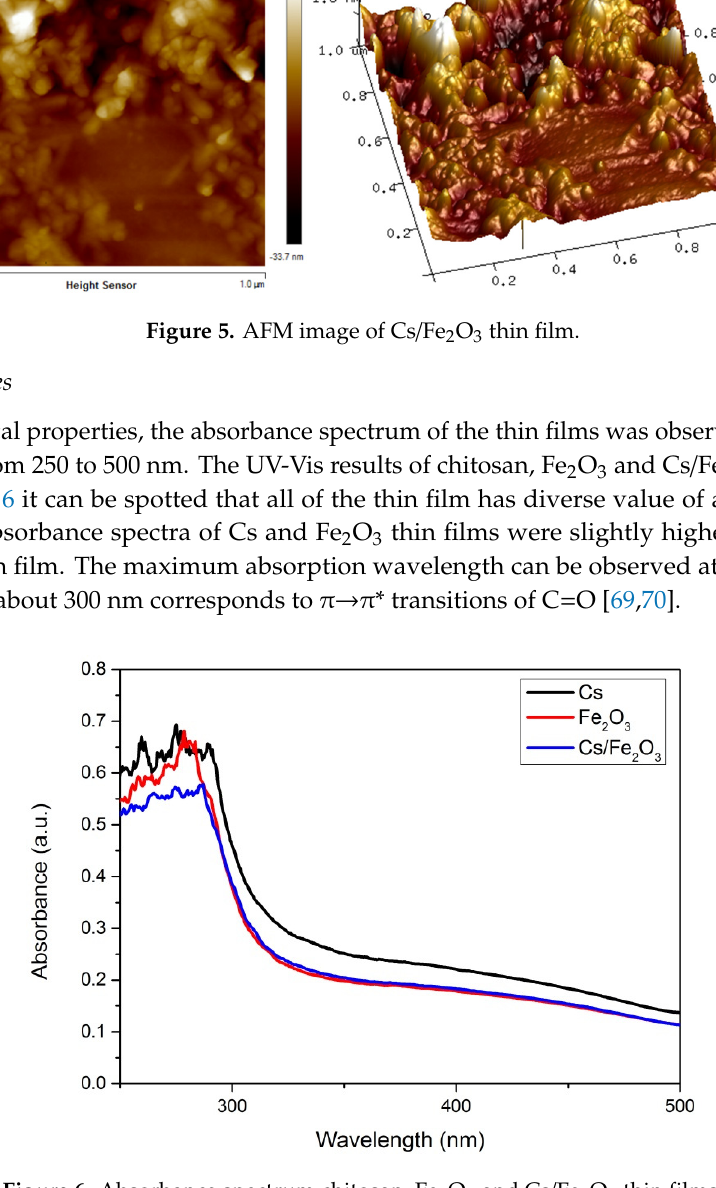
Figure 6. Absorbance spectrum chitosan, Fe 2 O 3 and Cs/Fe 2 O 3 thin films.